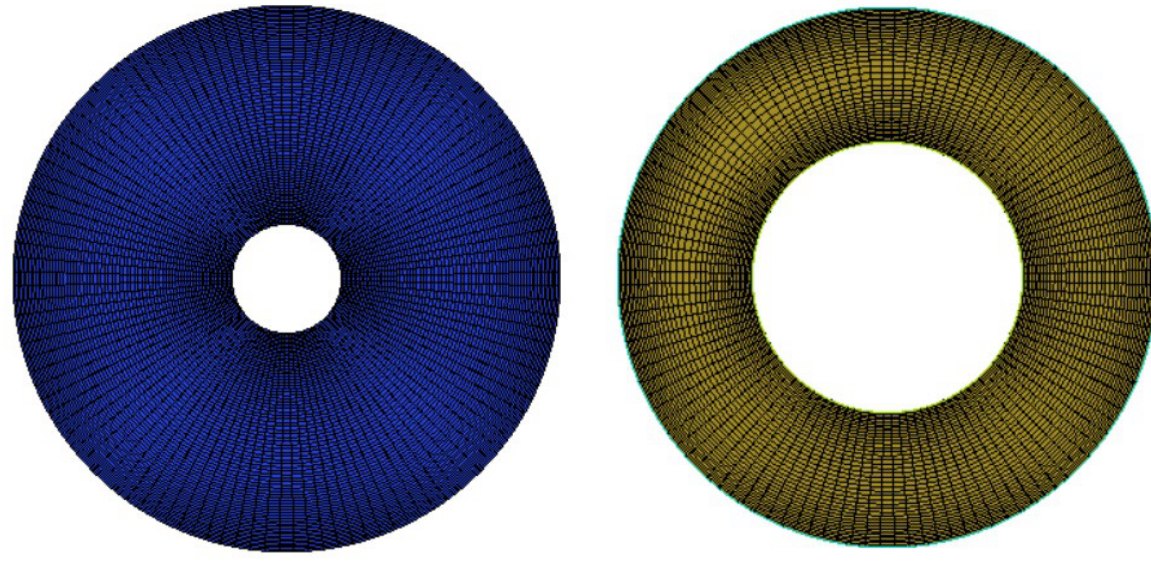
Figure 4. Schematic diagram of boundary layer and porous media zone mesh refinement.